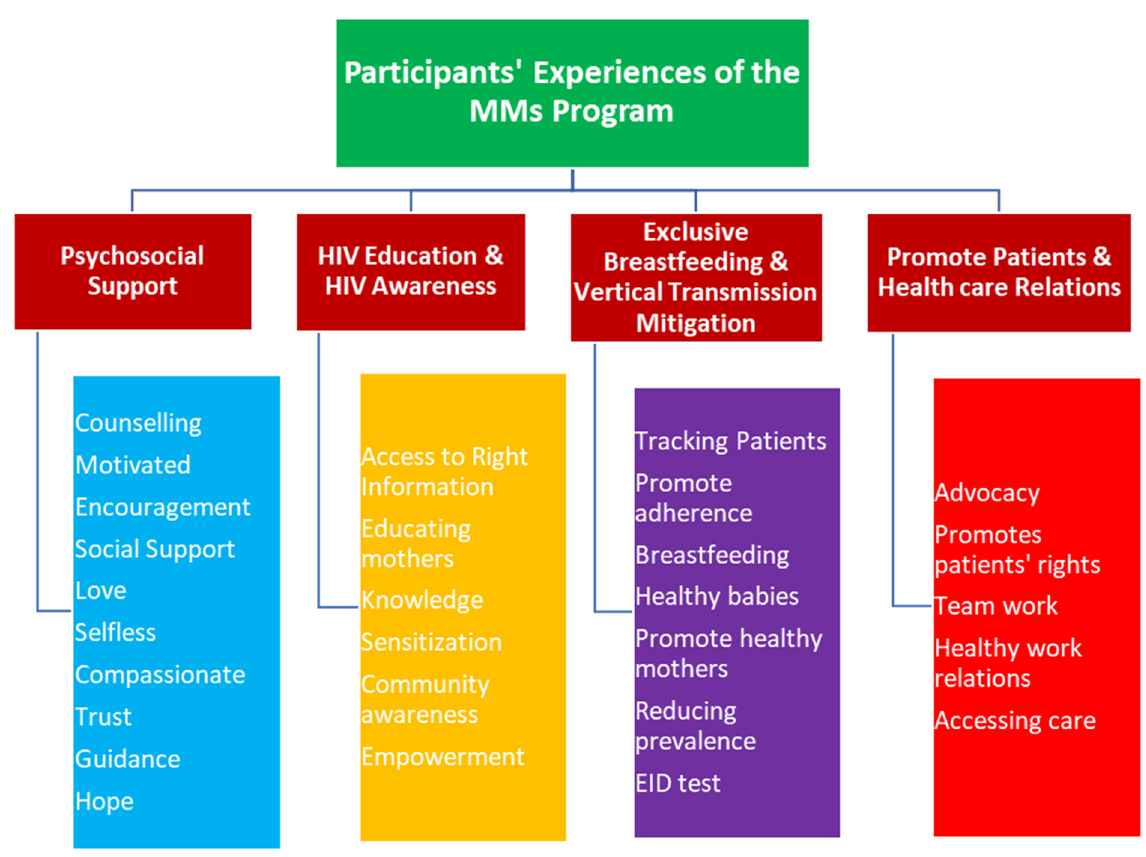
Figure 1. Summary of participants’ experiences of the Nigerian Department of Defense (DoD) Mentor Mothers (MMs) program.